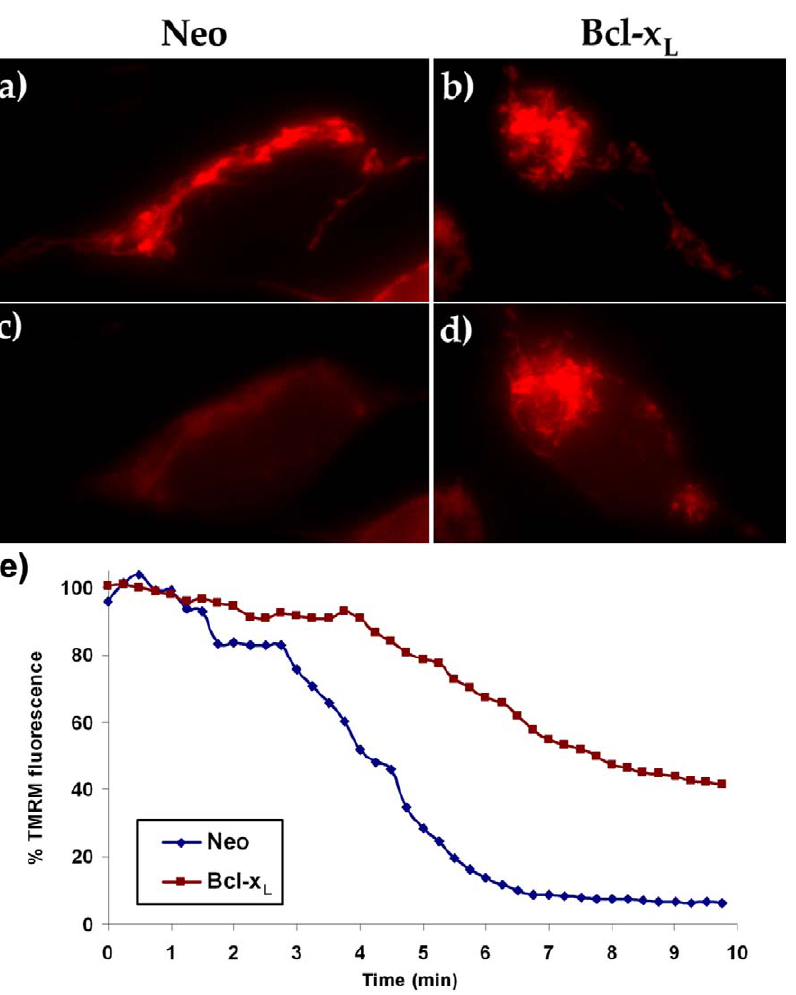
Figure 5. Bcl-x L prevents ionomycin-induced lost in DY m . TMRM fluorescence in SH-SY5Y/Neo (a and c) and SH-SY5Y/Bcl-x L (b and d) cells exposed to 2 m M ionomycin at time 0 h. a) and b) time =0; c) and d) time =5 min. e) Time-course of TMRM fluorescence in mitochondria-rich cytoplasm versus the nucleus that is considered background in SH-SY5Y/Neo (red trace) and SH-SY5Y/Bcl-x L (blue trace) cells. The complete videos for these experiments can be found in Supporting information Video S1 and Video S2. This experiment was repeated 4 times with similar results.